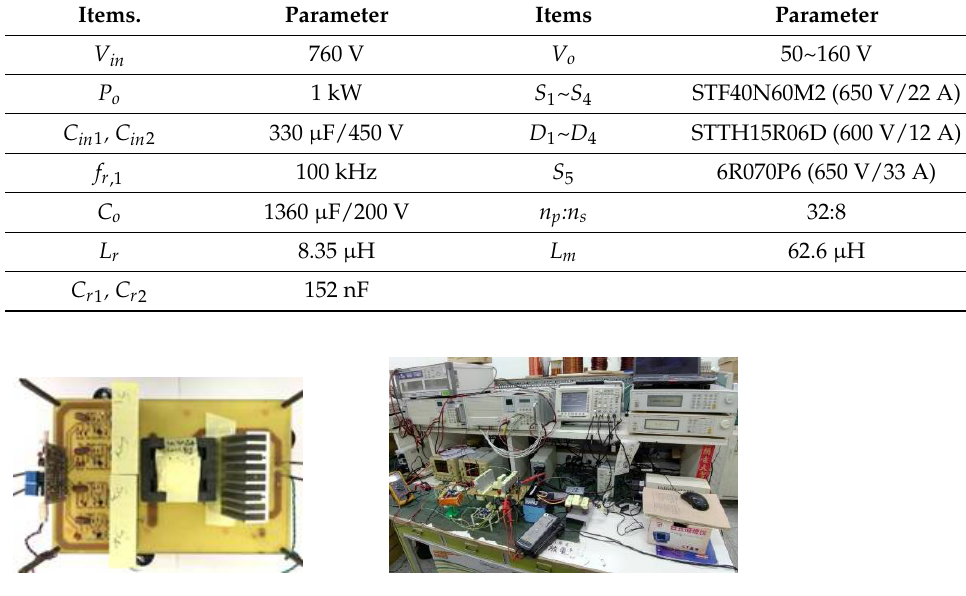
Figure 7. Picture of the prototype circuit in the laboratory test.